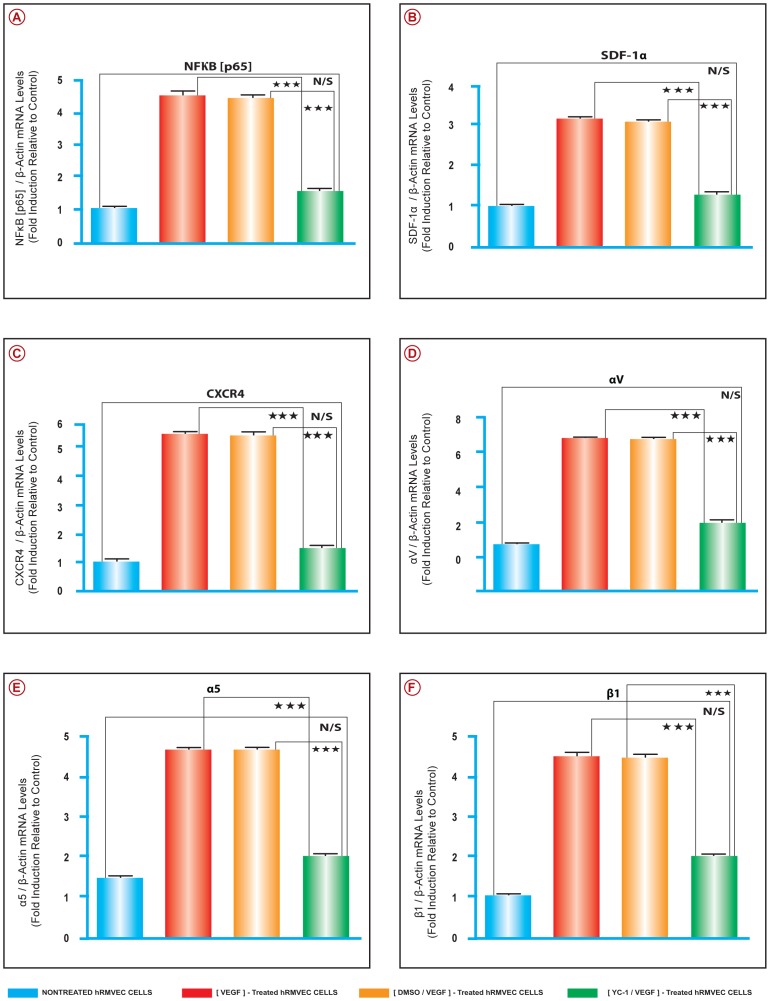
YC-1 Inhibits the Expression of NFκB/p65, SDF-1, CXCR4, αV, α5, and β1 in VEGF Stimulated Cells. A–F. Real Time RT-PCR Analysis.The mRNA levels for NFκB/p65, SDF-1, CXCR4, FAK, αV, α5, β3, β1, EPO, ET-1, MMP-9, was quantified by Real time RT-PCR. The mRNA levels of these genes were upregulated in the cells that were cultured in the presence of VEGF [30 ng/ml] and either treated with DMSO [0.2%], or SN50M [20 µM]. Whereas the cells that were cultured in medium only exhibited significant low mRNA levels. Treatment of VEGF-stimulated cells with SN50 [20 µM] or YC-1 [100 µM] resulted in a significant downregulation of the mRNA expression of the genes listed above, as compared to respective controls; SN50M and DMSO-treated cells, respectively. ANOVA was used for statistical analyses. Mean ± SEM of mRNA level normalized to β-actin were calculated, [***P<0.001 and **P<0.01, as compared to respective controls]. Data are representative of 3 independent experiments.